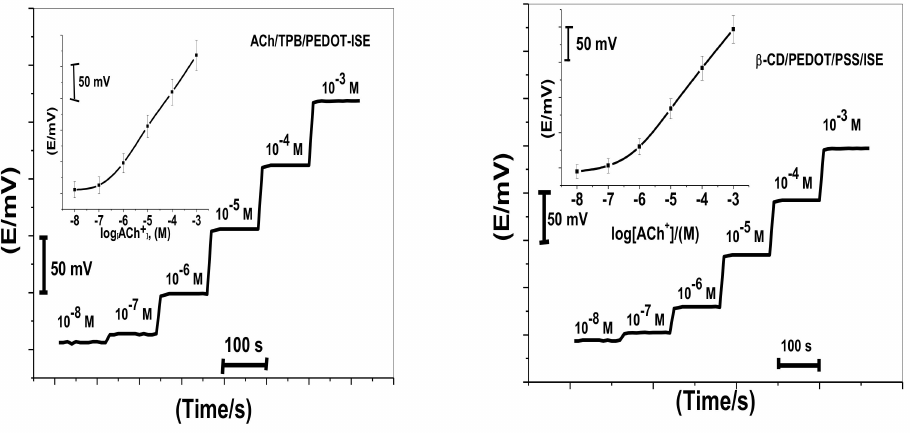
Figure 1. Potentiometric responses of the proposed sensors. Table 2. Potentiometric response characteristics of acetylcholine membrane-based